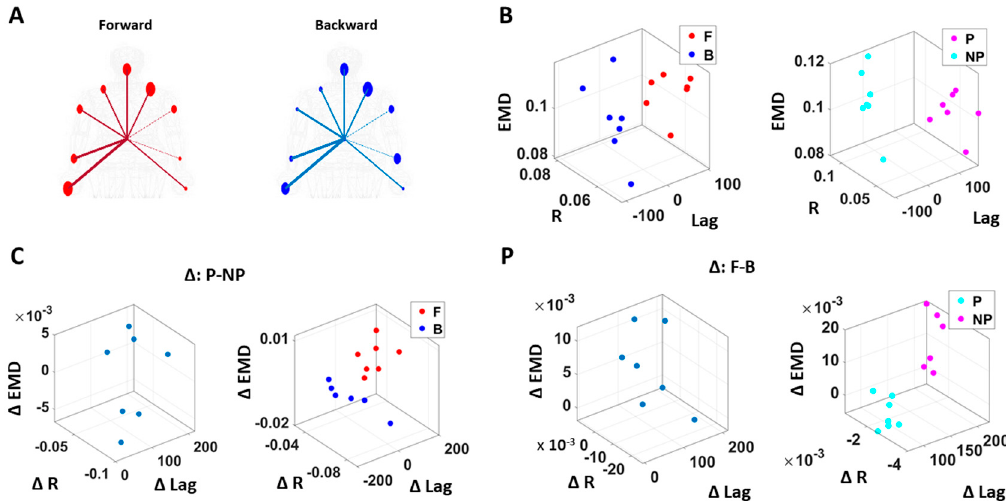
Figure 8. Di ff erentiation of spatial and temporal connectivity within the kinematics-heart network according to levels of motor intent. ( A ) Network visualization of a right-handed representative participant. 1 / EMD is represented by the node size, and median correlation is represented by the line weight. The color of edges indicates the temporal directionality between signals, where red indicates that heart leads the body linear speed and blue indicates that body linear speed leads the heart signals. ( B ) Median EMD (z-axis) and correlation (x-axis) and lag (y-axis) for each participant’s movement segment (left) and di ff erent sides (right). There is an overall pattern where higher motor intent (denoted by red for forward motions, and pink for performing side) is exhibited by lower correlations and EKG leading the kinematics signal (i.e., lag is positive value). ( C ) Median EMD, correlation, and lag di ff erence for di ff erent sides (left), and this di ff erence separated by movement segment (right). We find a pattern where pairwise EMD show higher di ff erentiation under higher motor intent on the performing side, but only when forward motion was made. ( D ) Median EMD, correlation, and lag di ff erence for di ff erent movement segments (left), and this di ff erence separated by sides (right). We find a pattern where pairwise EMD show higher di ff erentiation under lower motor intent on the non-performing side, but only when the backward motion was made.